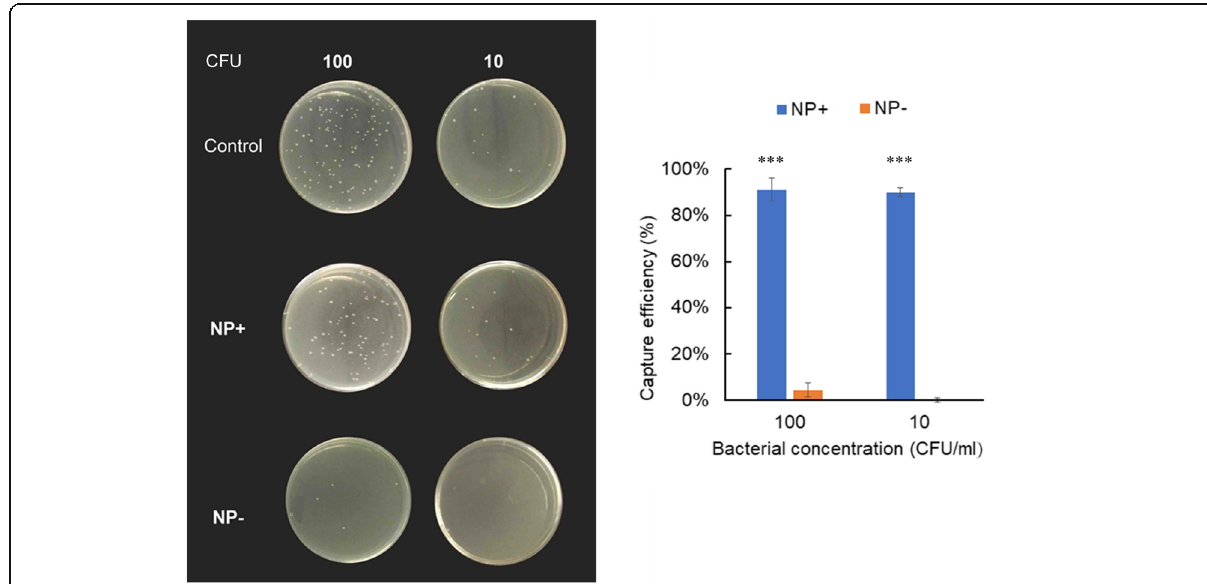
Fig. 7 Capture efficiencies of E. coli by NP+ or NP − at ultralow concentrations. The left image is the photograph of LB-agar plates coated with E. coli captured by NP+ and NP − . The right image showed the E. coli capture efficiency of NPs (40 μ g/mL) with ultralow concentrations of bacteria. E. coli (10 and 100 CFU in 1 mL PBS solution) without NP incubation was counted as 100% and served as control. *** P <